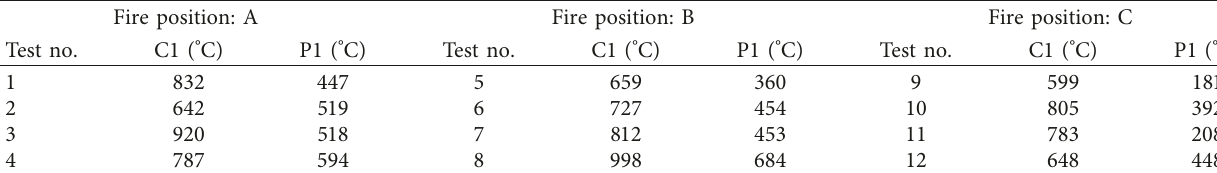
Figure 7: Temperature distribution with different ventilation. (a) C1. (b) P1. Table 2: Maximum temperature at the ceiling (Point C1) and platform (Point